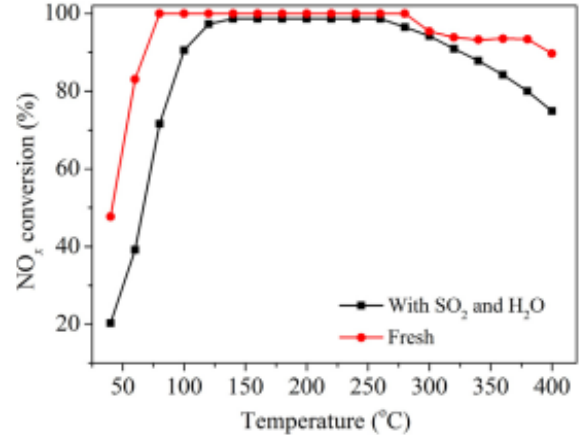
Figure 34. Effects of SO 2 and H 2 O on the NO x conversion of W(0.25)–Mn(0.25)–Ti(0.5) at GHSV of 25,000 h − 1 (Reaction conditions: [NO] = [NH 3 ] = 1000 ppm, [O 2 ] = 5 vol %, [SO 2 ] = 100 ppm, [H 2 O] = 10 vol %, in He as balance). (Reproduced with permission from Reference [55], Copyright 2016,Elsevier.).